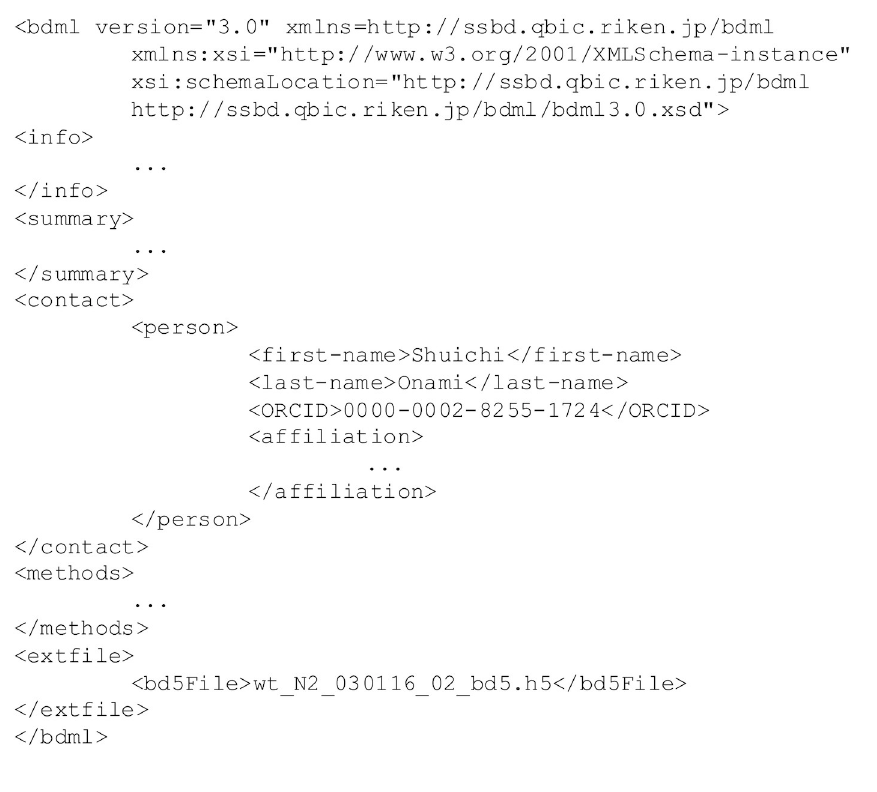
Fig 7. A skeleton of a BDML version 3.0 file for describing meta-information. This version allows the use of an external file for describing the data itself, designation of multiple contact persons, and the use of ORCID, a unique persistent digital identifier of the research